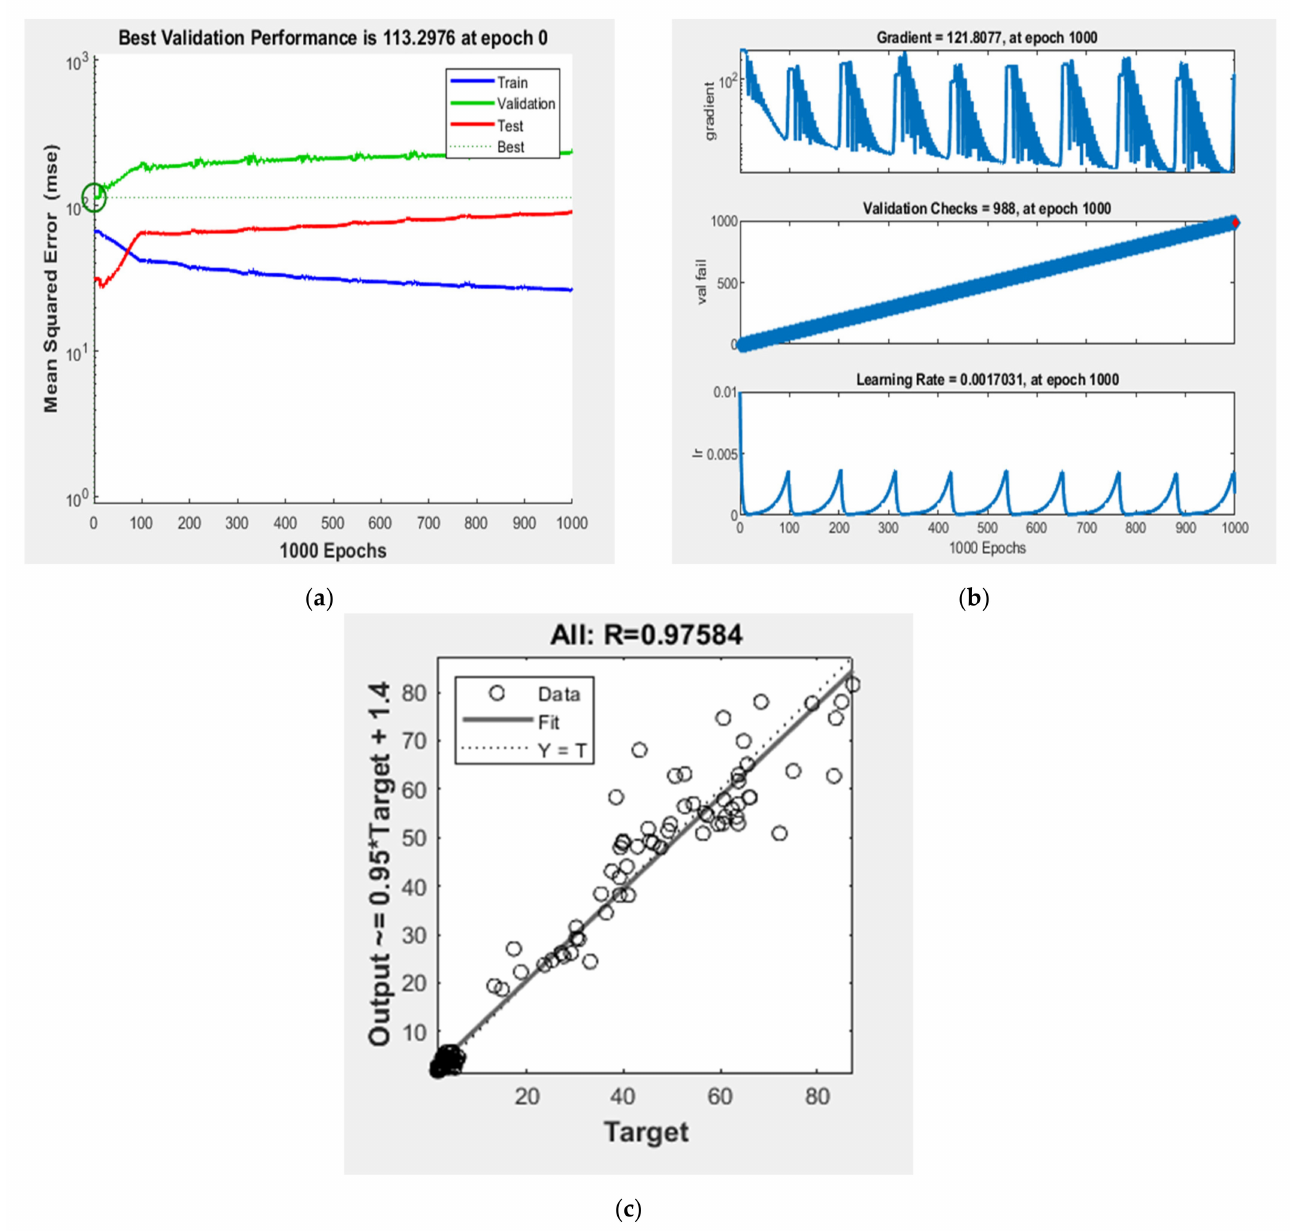
Figure 4. Training performances of ANN [7:14:2] model, ( a ) nest validation performance; ( b ) training state; ( c )